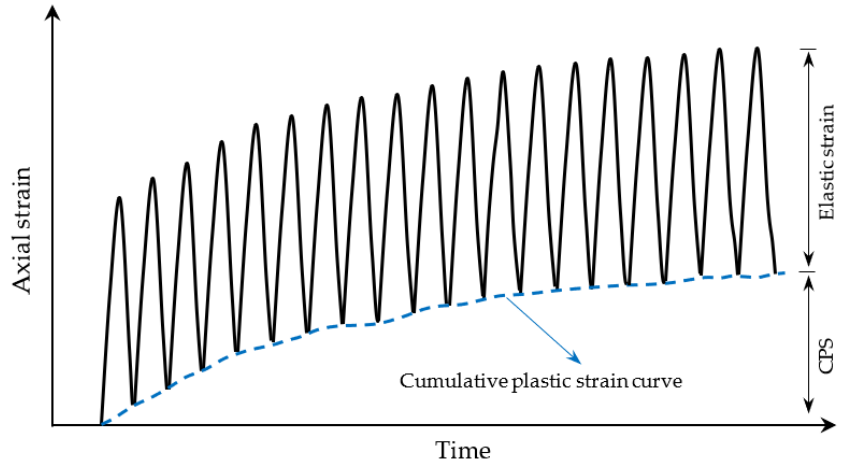
Figure 4. Variation in axial strain with time.